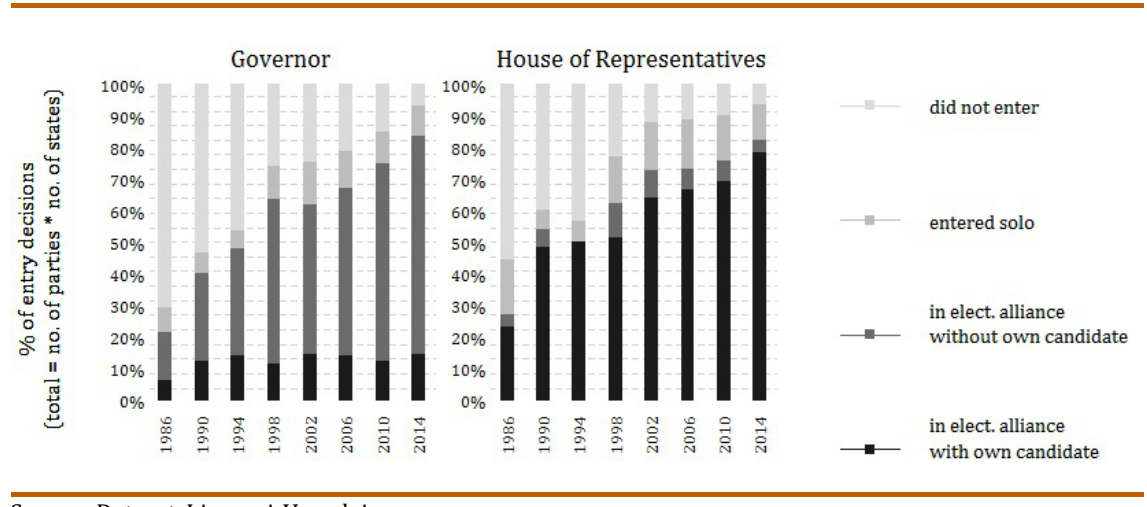
Graph 2. Cumulative histogram: decisions relative to electoral ’entries’ for Governor and House of